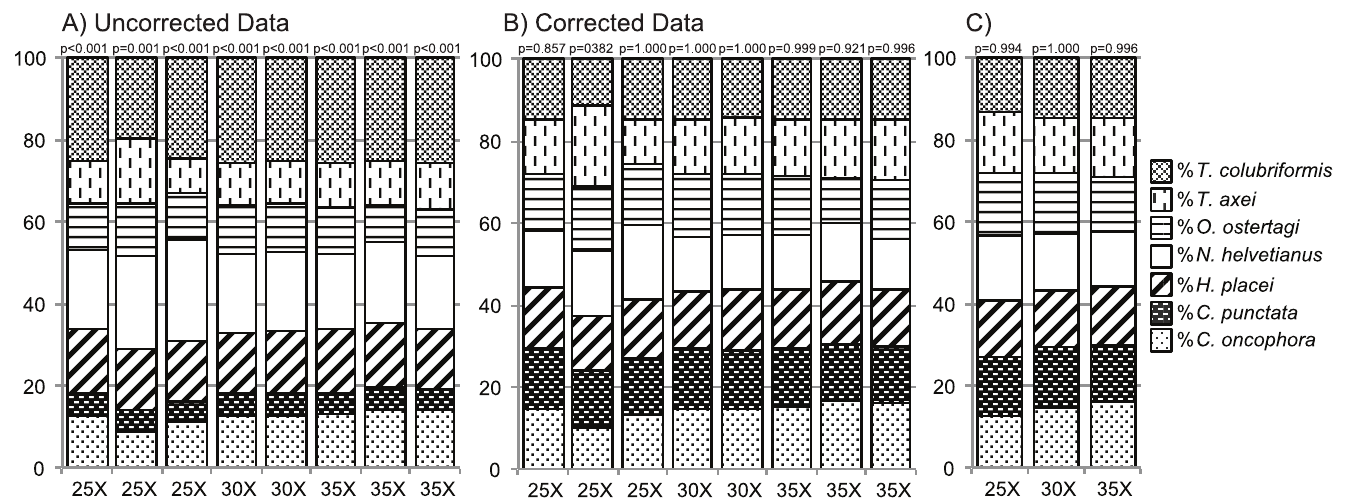
Fig 2. Assessment of sequence representation bias and the determination of correction factors for the amplicon sequencing assay. A DNA lysate was prepared from a pool of 140 L3 larvae comprising 20 individual L3 larvae from each of the following species; N . helvetianus , C . oncophora , T . axei , T . colubriformis , C . punctata , O . ostertagi and H . placei . The sequencing assay was applied to this lysate eight times; three, two and three times at 25, 30 and 35 cycles of amplification respectively (as denoted on the x-axis of panels A and B). 2A . The chart shows the species proportions as determined by the actual number of ITS-2 rDNA sequences generated by the amplicon sequencing assay. The p-values above each column indicate whether the species proportions, as determined by the uncorrected numbers of ITS-2 rDNA sequences generated, are statistically different from the actual proportions of larvae in the pool (non-parametric Chi-square test with significant differences between expected and observed results (p (cid:1) 0.001) for all replicates). 2B . The chart shows the same data as in panel 2A but following the application of a correction factor for each species. The correction factor was calculated for each species by dividing the true proportion of that species in the pool (based on counted larvae) by the mean proportion of Illumina sequences generated from the eight replicates (correction factor = %Actual / %Observed). The correction factors were: N . helvetianus = 0.68871028, C . onchophora = 1.183576925, T . axei = 1.296071418, T . colubriformis = 0.584257283, C . punctata = 2.779407405, O . ostertagi = 1.294841767 and H . placei = 0.919208106. Their application removed the significant variation (p > 0.05). The p-values above each column indicate whether the species proportions, as determined by the corrected numbers of ITS-2 rDNA sequences generated, are statistically different from the actual proportions of larvae in the pool (non-parametric Chi-square test). 2C . Replicates were grouped and averaged based on cycles of amplification. A one way ANOVA was performed to detect if number of cycles of amplification affected the proportional representation of each species with non-significant results ( N . helvetianus , F = 1.200, p = 0.375; C . oncophora , F = 3.035, p = 0.137; T . axei , F = 0.098, p = 0.908; T . colubriformis , F = 0.752, p = 0.518; C . punctata , F = 2.683, p = 0.162; O . ostertagi , F = 2.501, p = 0.177; H . placei , F = 1.672, p =